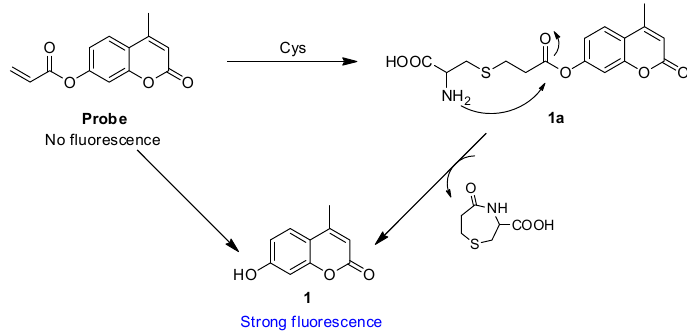
Scheme 2. Proposed reaction mechanism of the probe with Cys.